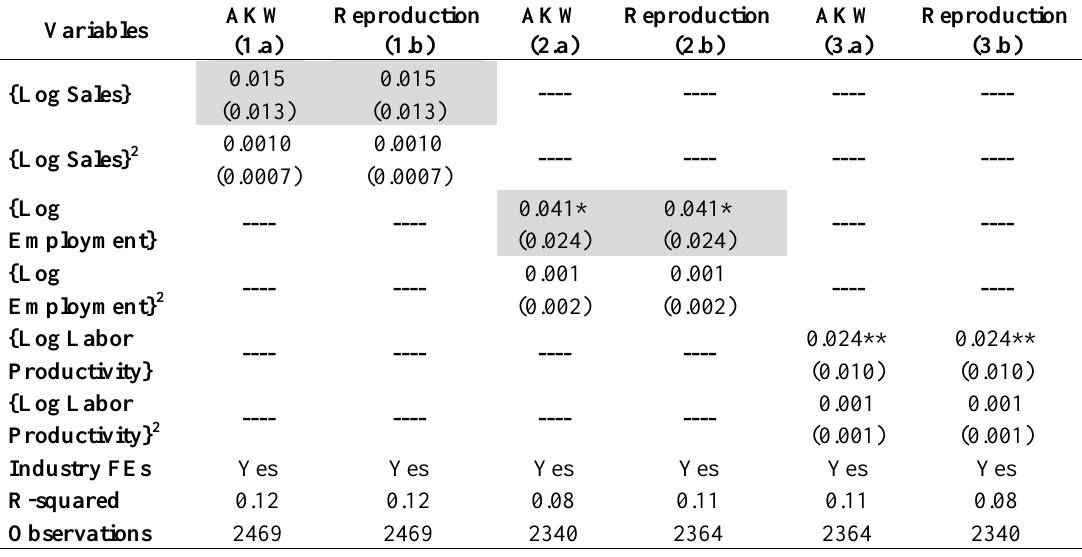
Table 1 . Reproduction of AKW’s results: Prediction